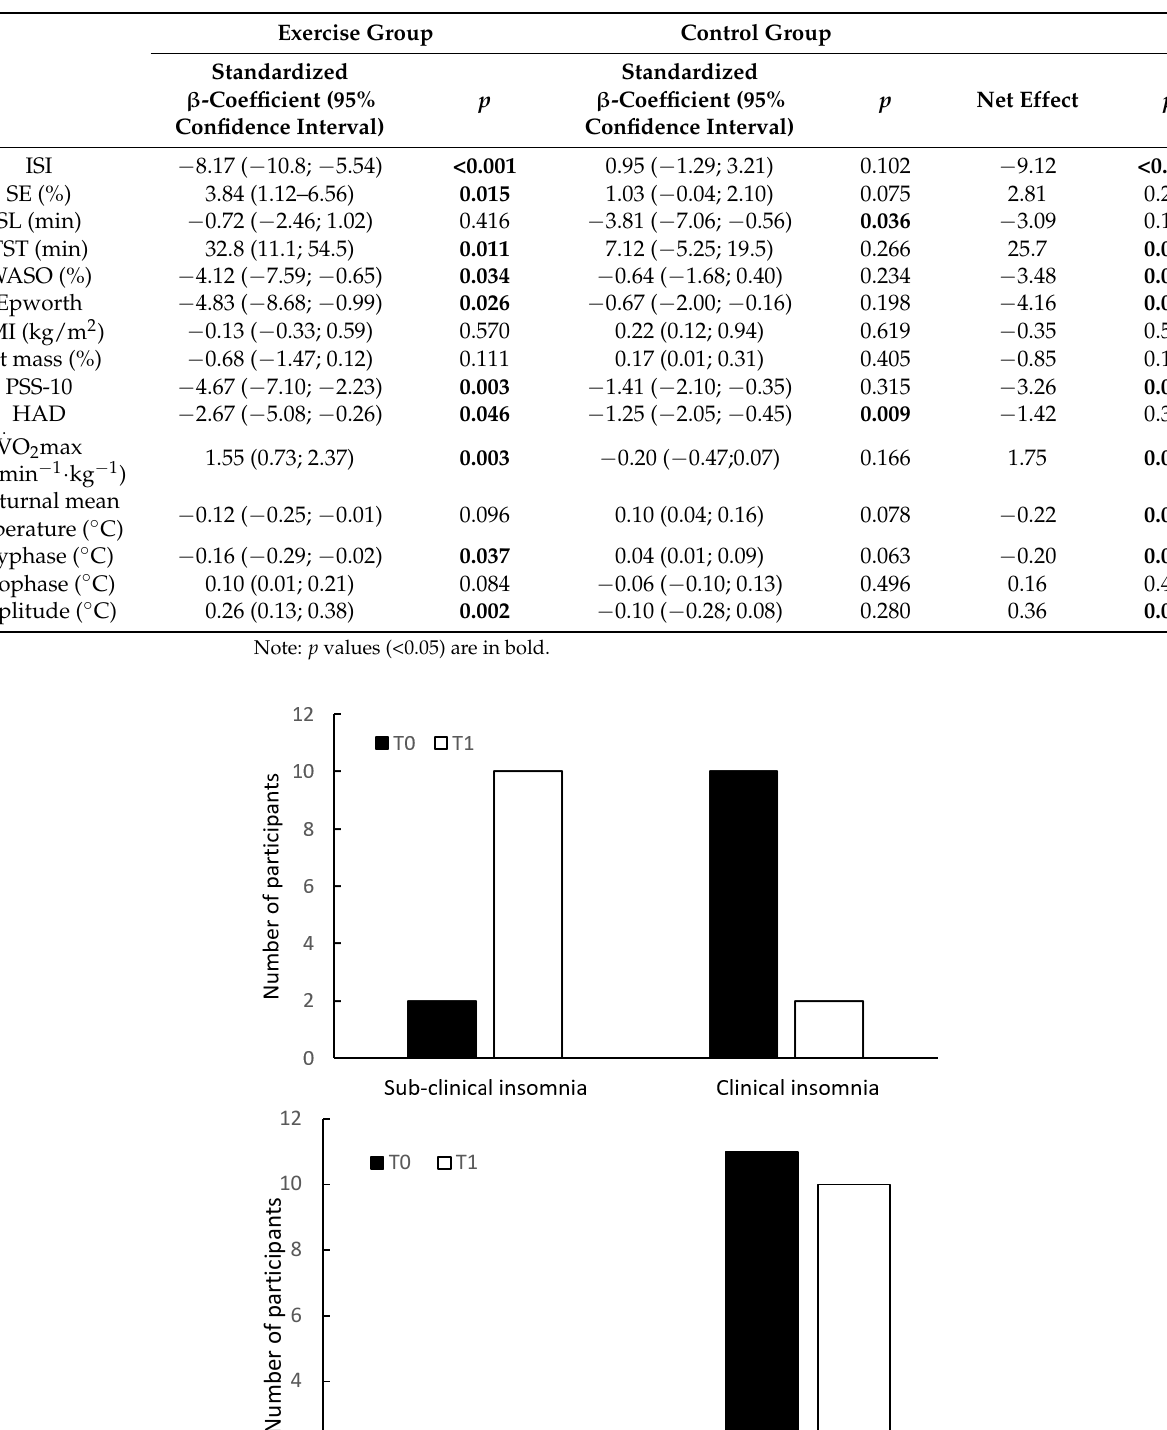
Table 2. Standardized β -Coefficient (95% confidence interval) of changes in variables by group and differences in changes between the two group.